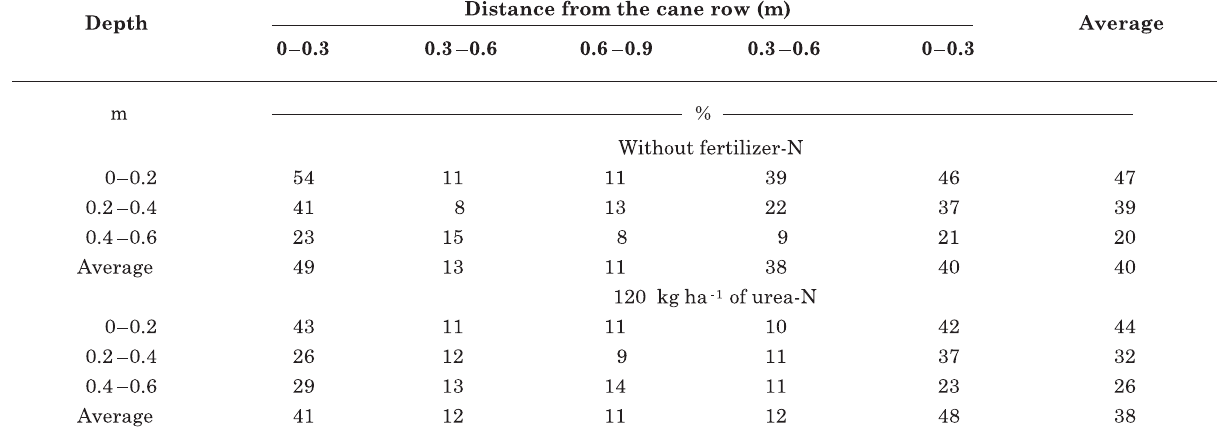
Table 8. Percentage of metabolically active roots of the total mass found at each location at sugar cane harvest, in terms of nitrogen fertilization at planting, by depth and distance from the